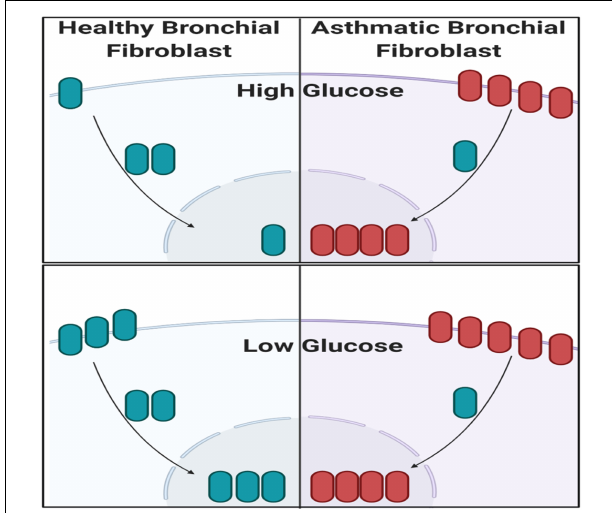
FIGURE 14 | Schematic summary of CTNNB1 intracellular localization in healthy and asthmatic bronchial fibroblasts under high- versus low-glucose culture conditions as measured by immunofluorescence and immunoblot. Created with